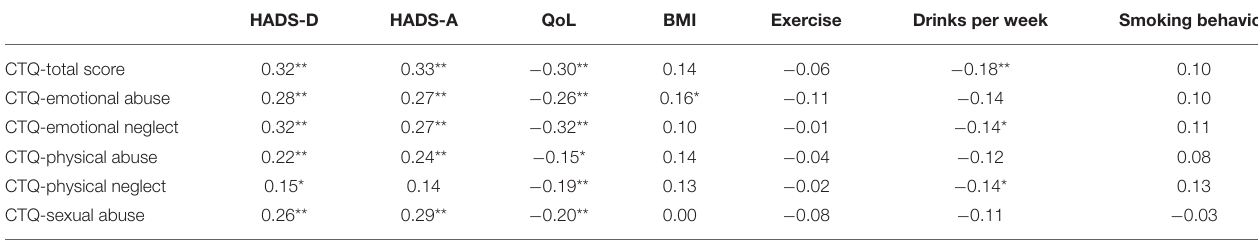
TABLE 3 | Results of correlation analysis (Pearson’s r) between child maltreatment, psychological well-being and health behavior ( N =